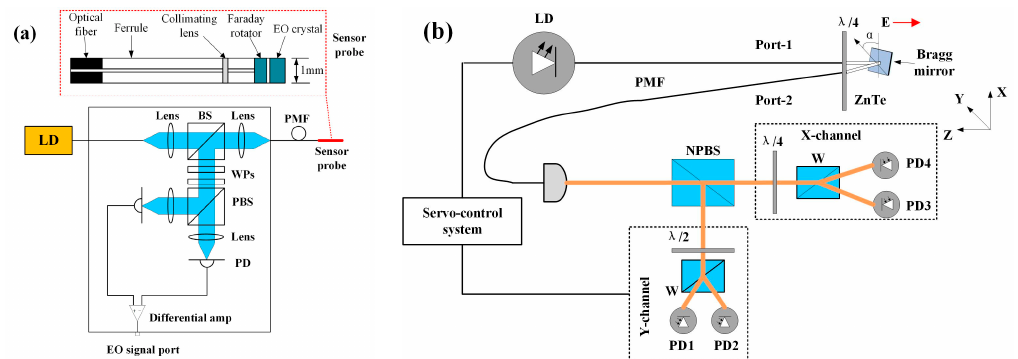
Figure 12. Sensor probe and sensing system ( a ) based on CdTe crystal [91] and ( b ) sensing system of two-dimensional electric field using ZnTe crystal [92].